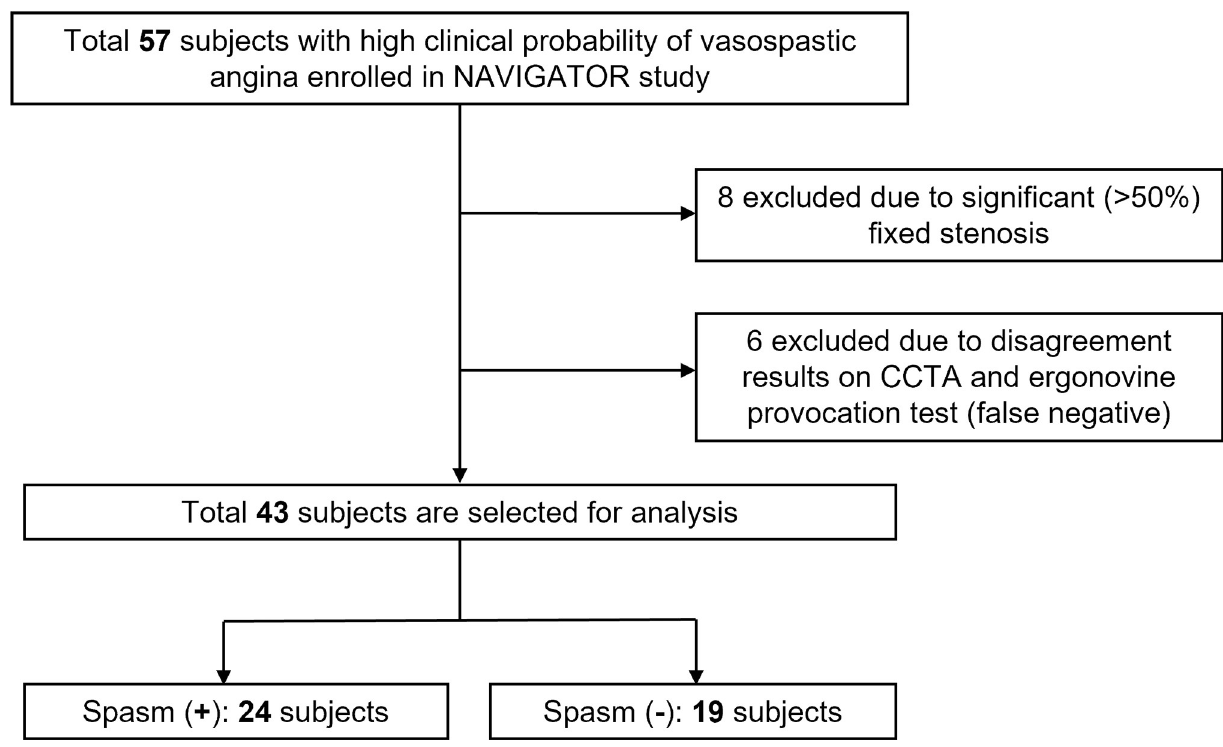
Fig 1. Patient flow diagram. We excluded 14 patients from the initial 57 patients due to significant fixed stenosis (n = 8) or inconsistency between the CCTA and spasm provocation test (n = 6). Finally, 43 patients were selected for analysis. CCTA, coronary computed tomography angiography.